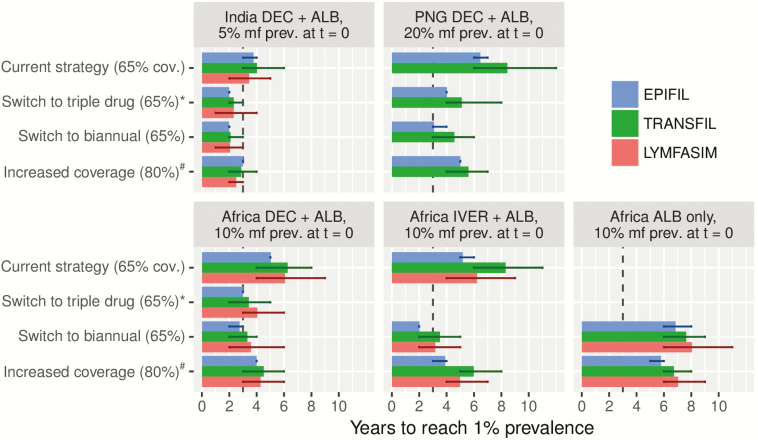
Required duration of mass drug administration (MDA) to bring microfilariae (mf) prevalence below the 1% critical threshold in treatment-naive settings, comparing the result from the 3 different models. The setting under consideration is specified in the caption of each subpanel, indicating the geographical region, recommended standard treatment regimen, and the precontrol mf prevalence considered. The current strategy (annual MDA with the recommended standard regimen at 65% coverage) is compared with alternative strategies differing in one aspect, including a switch to triple-drug regimen (ivermectin + diethylcarbamazine + albendazole; annual, 65% coverage), switch to biannual MDA (standard regimen, 65% coverage), or increased coverage of 80% (annual, standard regimen). Vertical line at t = 3 indicates the target year of elimination (ie, 2020, 3 years from the time of writing this paper). Error bars indicate the 90% prediction interval as calculated through bootstrapping. aSimulations for triple-drug scenarios were done with optimistic efficacy assumptions, as provided in Table 1. bImpact of increased coverage is shown for annual MDA, except for the “Africa ALB only” region, where it is shown for biannual MDA. Abbreviations: ALB, albendazole; cov., coverage; DEC, diethylcarbamazine; IVER, ivermectin; mf, microfilariae; PNG, Papua New Guinea; prev., prevalence.